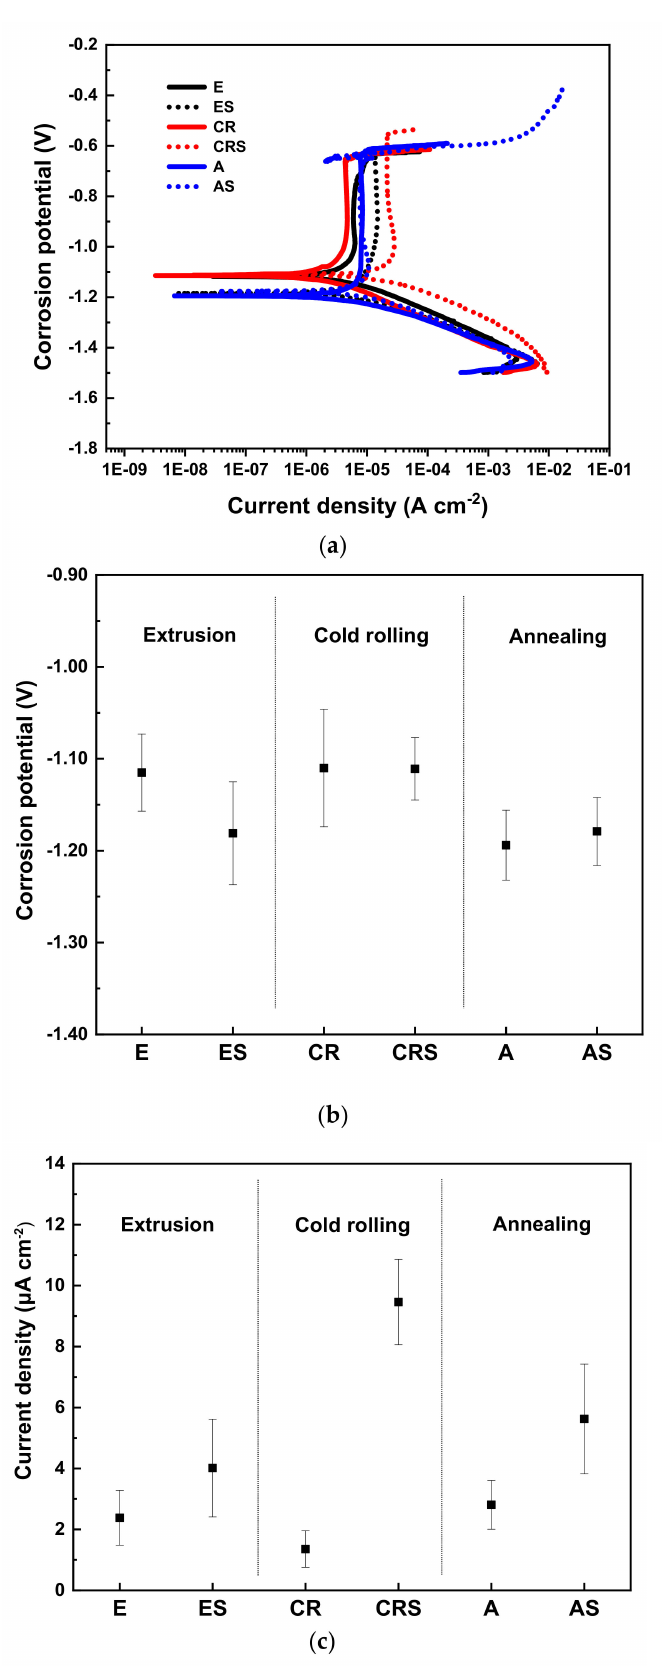
Figure 6. Electrochemical property test of Al-6Mg alloy for each manufacturing process. ( a ) Potentio- dynamic polarization curve; ( b ) corrosion potential ( c ); current